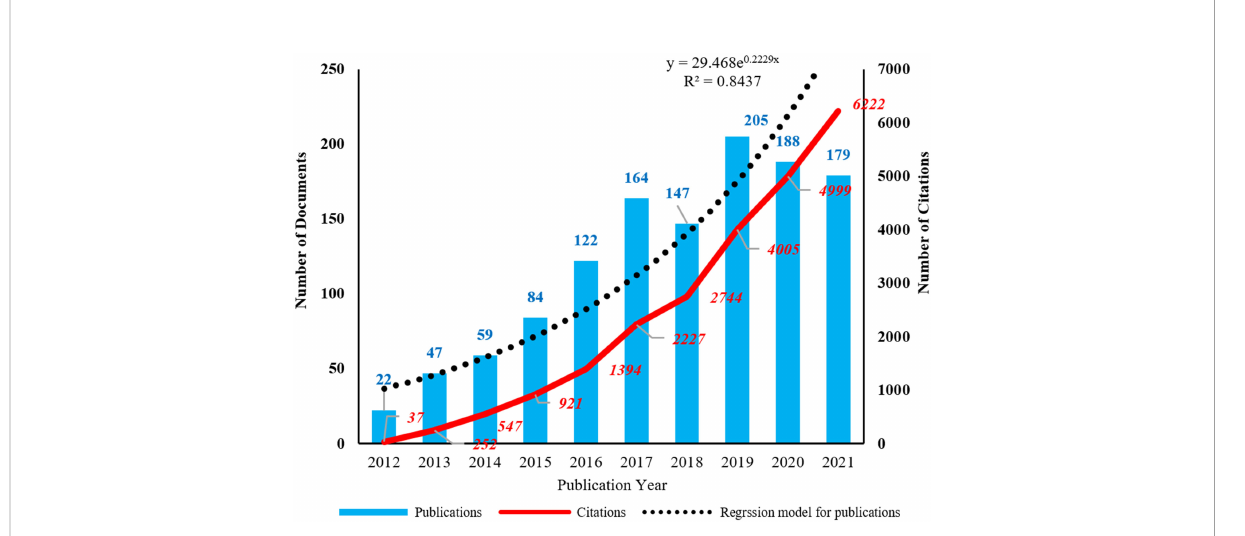
FIGURE 1 The annual distribution of publications and citations. The corresponding regression model for publications is y = 29.648e 0.2229x (R 2 =